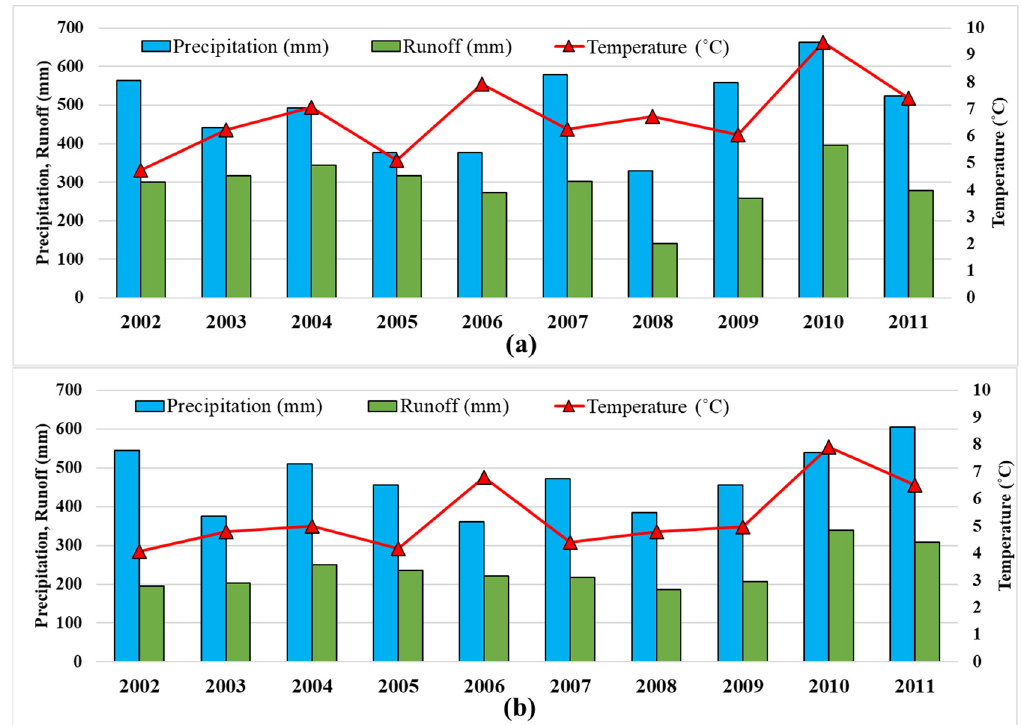
Figure 2. Hydro-meteorological conditions of ( a ) Murat and ( b ) Karasu basin.